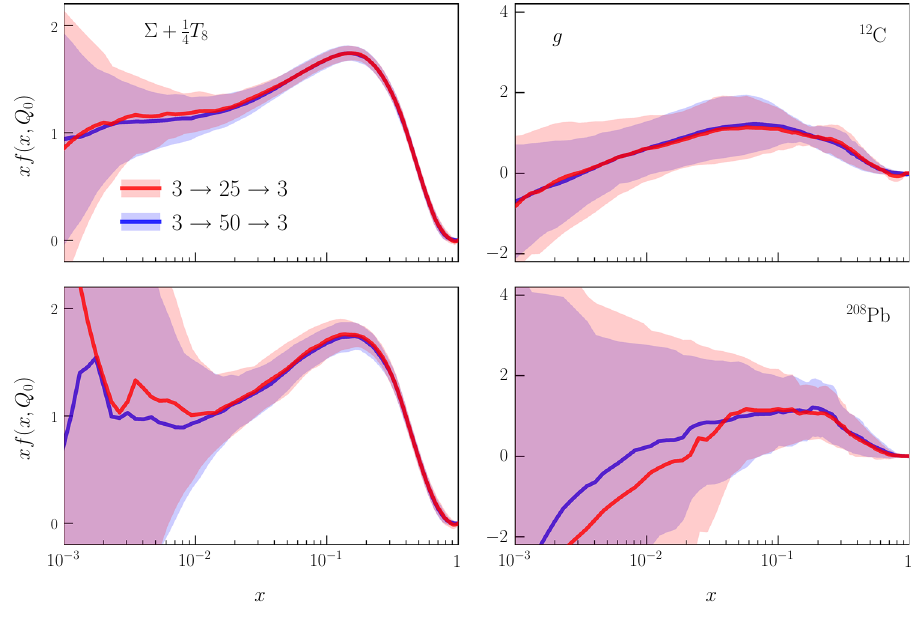
Fig. 21 Dependence of the nNNPDF1.0 results at the input scale Q 0 = 1 GeV with respect to the choice of neural network architecture. We compare the baseline results obtained with a 3–25–3 architecture (solid red line and shaded band), with the corresponding ones using a 3-50-3 architecture (solid blue line and shaded band) for 12 C (top panels) and 208 Pb (bottom panels)